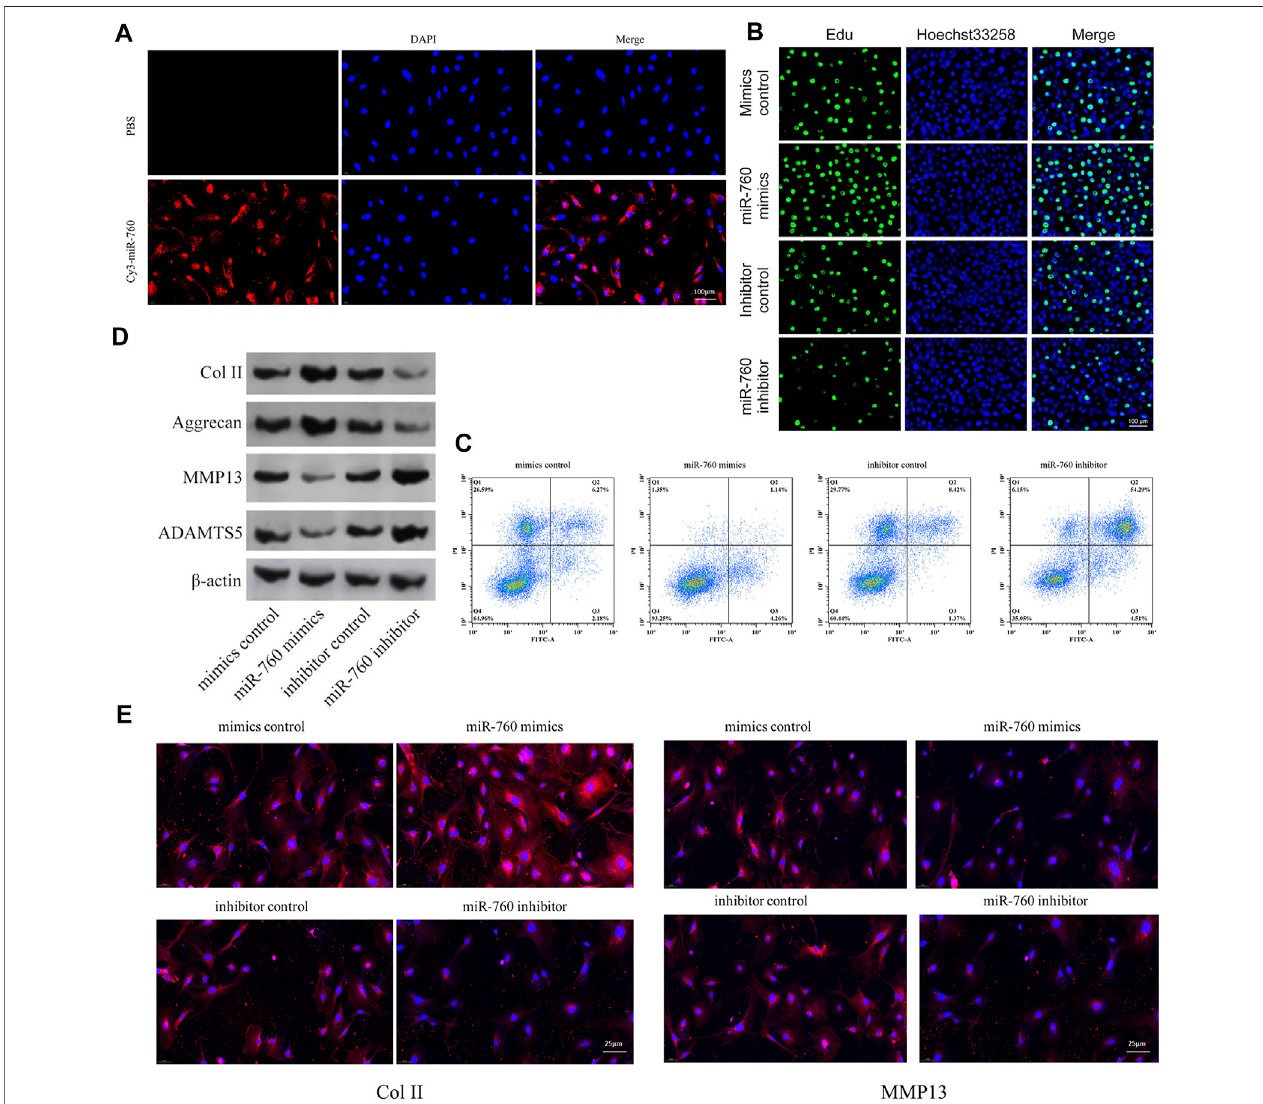
FIGURE 2 | In vitro in vitro study of miR-760. (A) Cy3 con fi rmed that miR-760 was transfected into primary cultured human NP cells. Scale bar = 100 μ m. (B) Cell proliferationwasanalyzedinmiR-760mimicsorinhibitortransfectedculturedprimaryhumanNPcellsusingEdUassays.n=3replicatespergroup.Scalebar=100 μ m. (C) Analysis of NP cells apoptosis was assayed by FCM. n = 3 replicates per group. (D) The expression levels of collagen II, aggrecan, MMP13, and ADAMT5 were detected by western blot. (E) The expression levels of collagen II and MMP13 were detected by the immuno fl uorescence. Scale bar = 25 μ